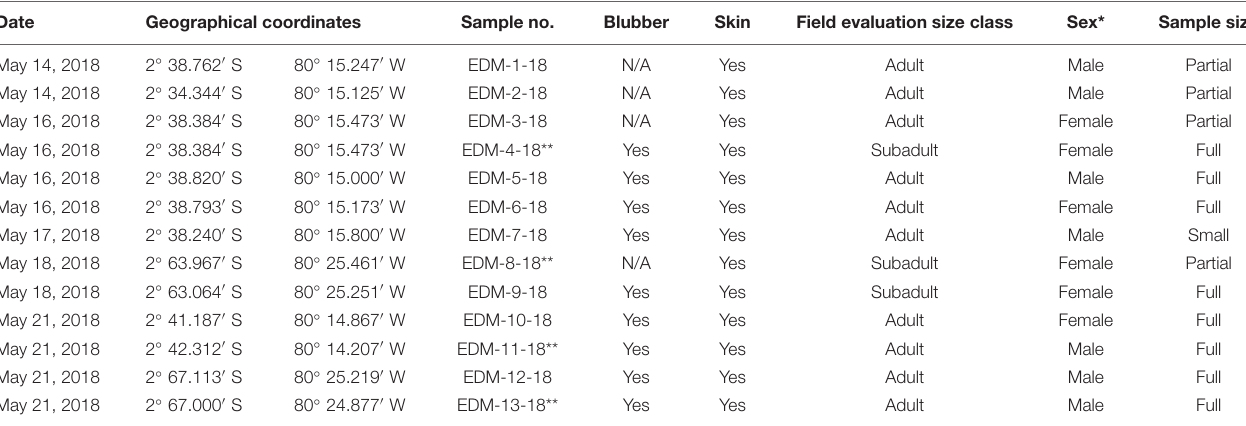
TABLE 1 | Field data for dart biopsy sampling of bottlenose dolphin in the El Morro Mangrove Wildlife Refuge (REVISEM) and Posorja Harbor waters during May